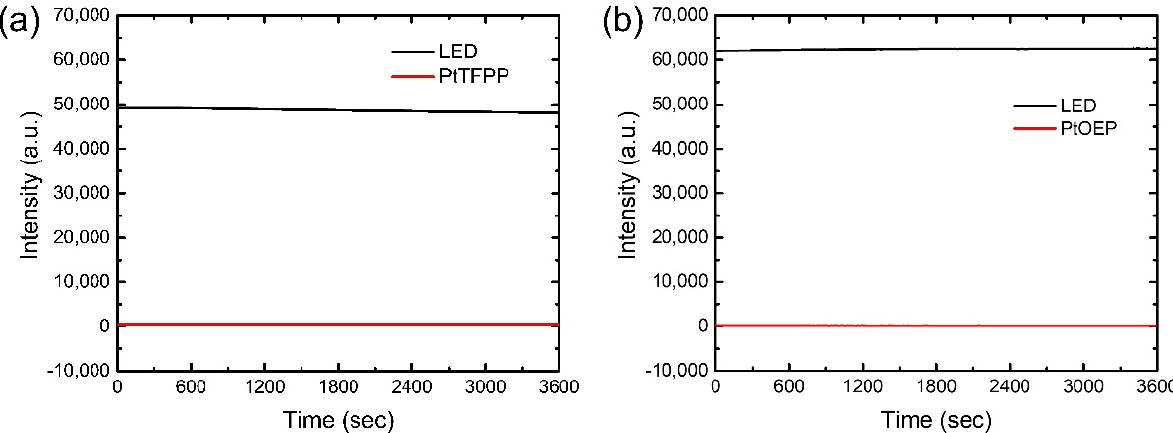
Figure 12. Photostability data of the oxygen sensors for ( a ) PtTFPP and ( b ) PtOEP on AAO membrane under 1 h continuous illumination.